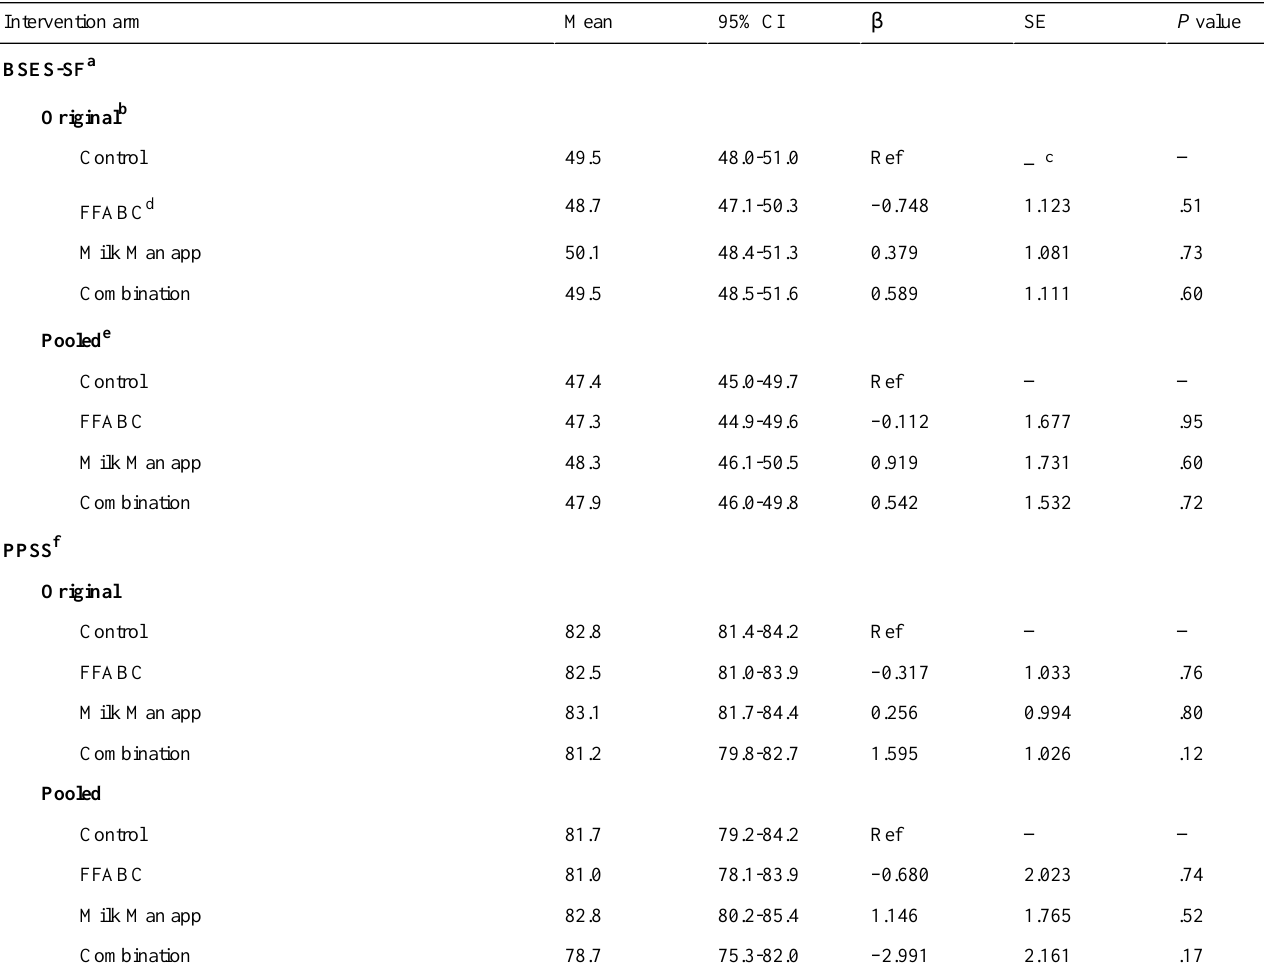
Table 3. Comparison of breastfeeding self-efficacy and postpartum partner support between control and intervention groups: intention-to-treat